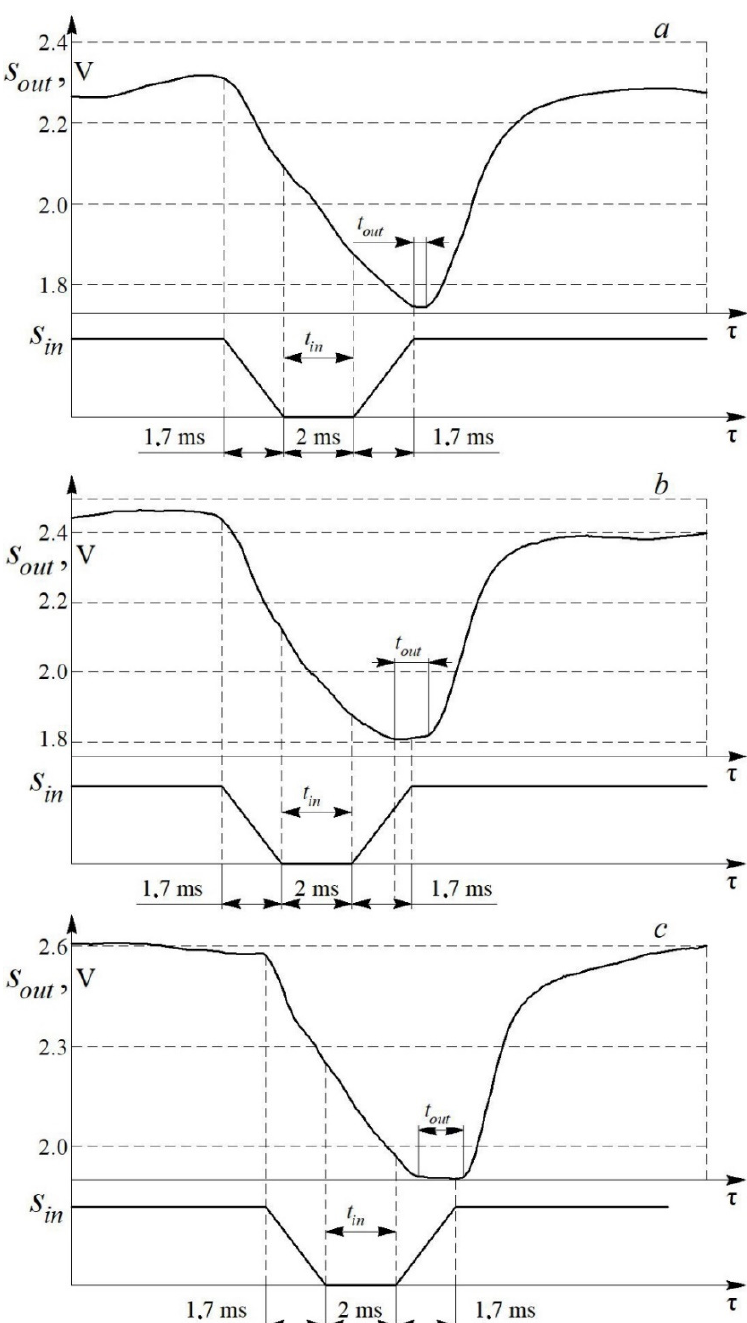
Figure 10. Comparison of the input S in and output S out signals of the measuring system for a one–piece blade ( τ p = 5.4 ms) and at different air flow velocities w : ( a )—17.8 m/s; ( b )—28 m/s; ( c )—40 m/s.